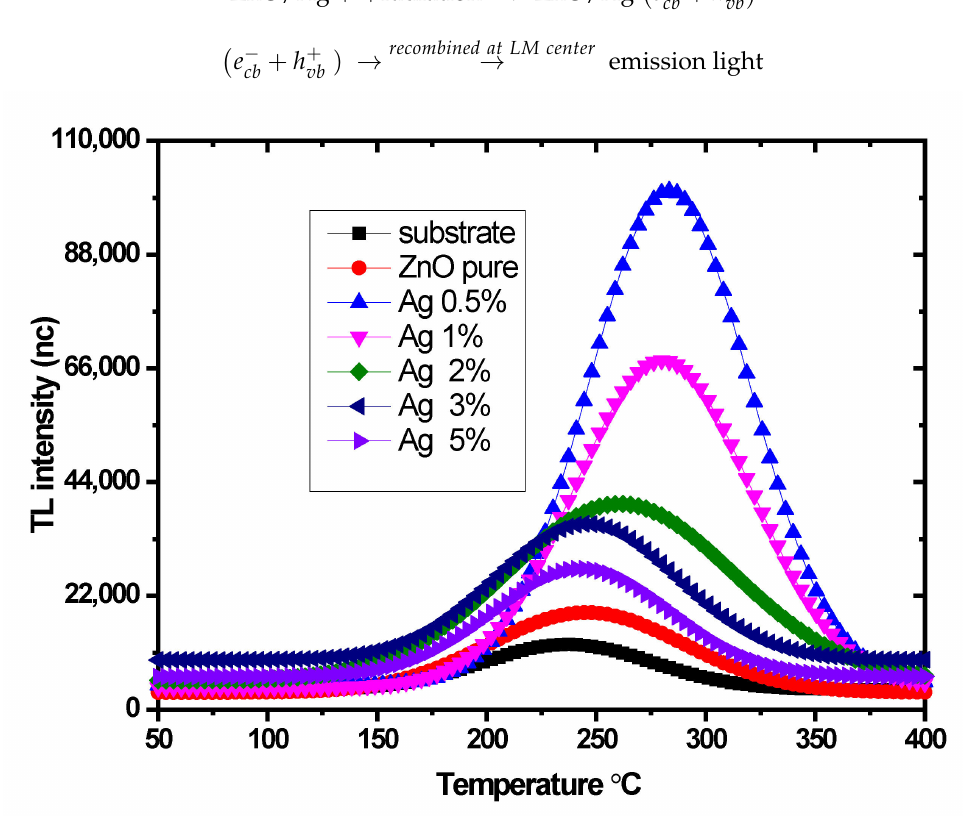
Figure 8. The glow curves of Ag-doped ZnO thin films with different concentrations of Ag